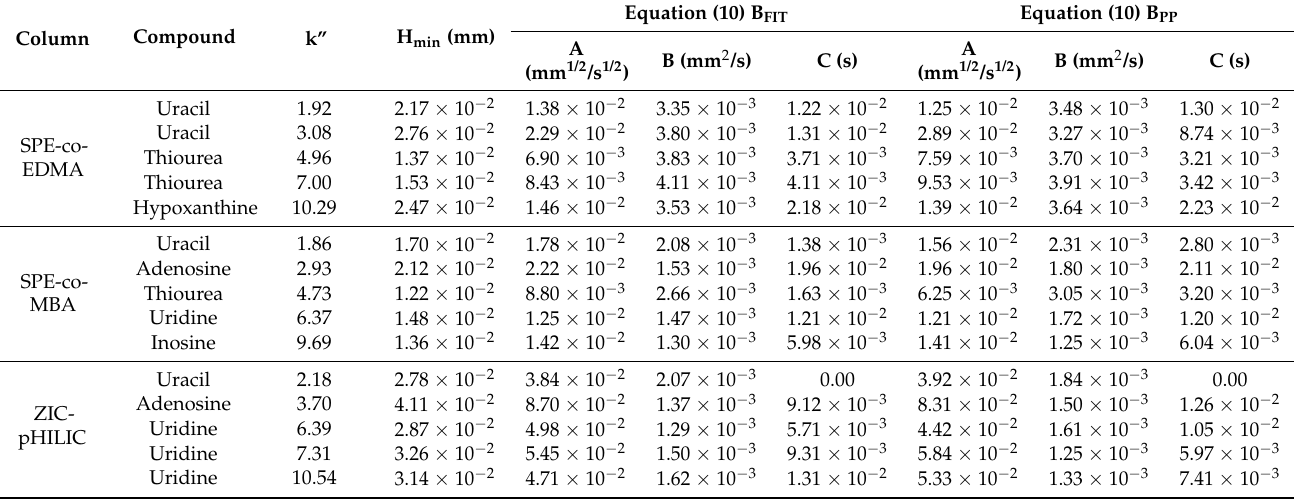
Table 2. A-, B- and C-term values obtained by fitting the experimental plate height data to Equation (10), either fitting all terms freely (BFIT) or fixing the B-term value to the value obtained by peak parking in [21], and subsequently fitting A and B